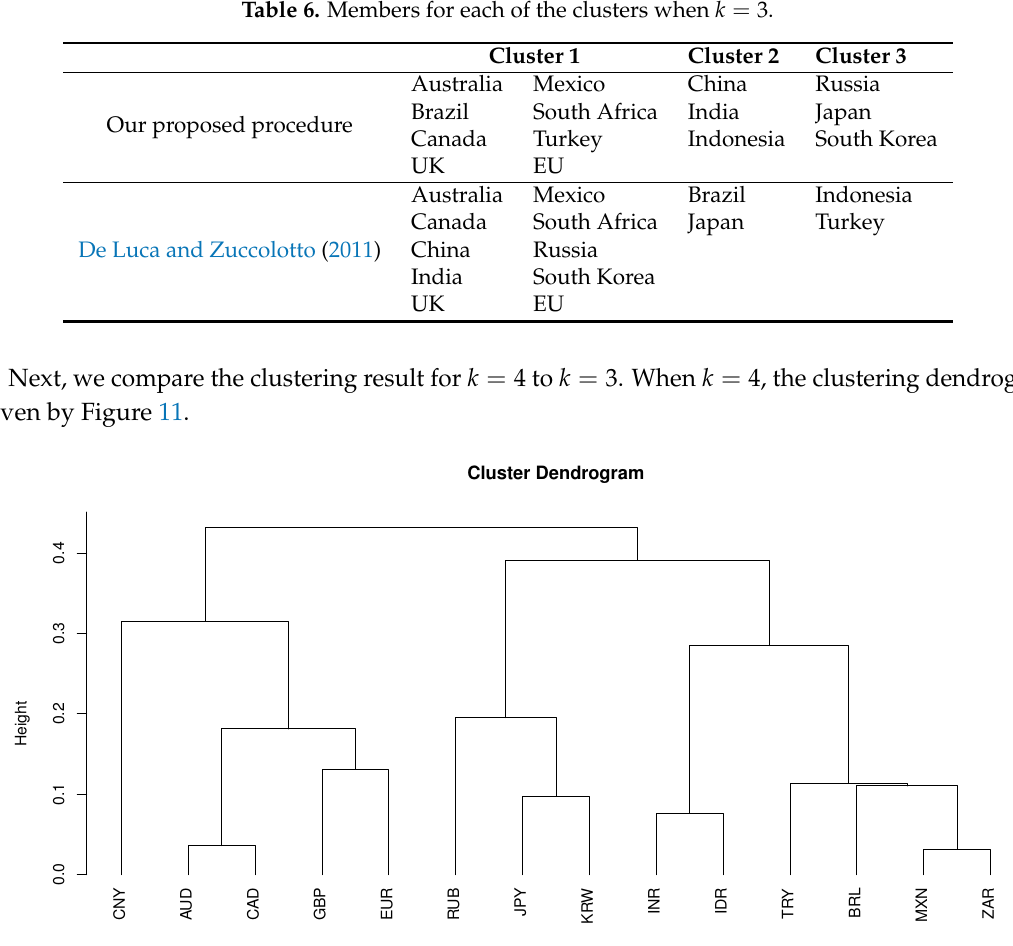
Figure 11. The dendrogram of the clustering procedure based on WNACut methods with affinity matrix as WLTMDs for k =